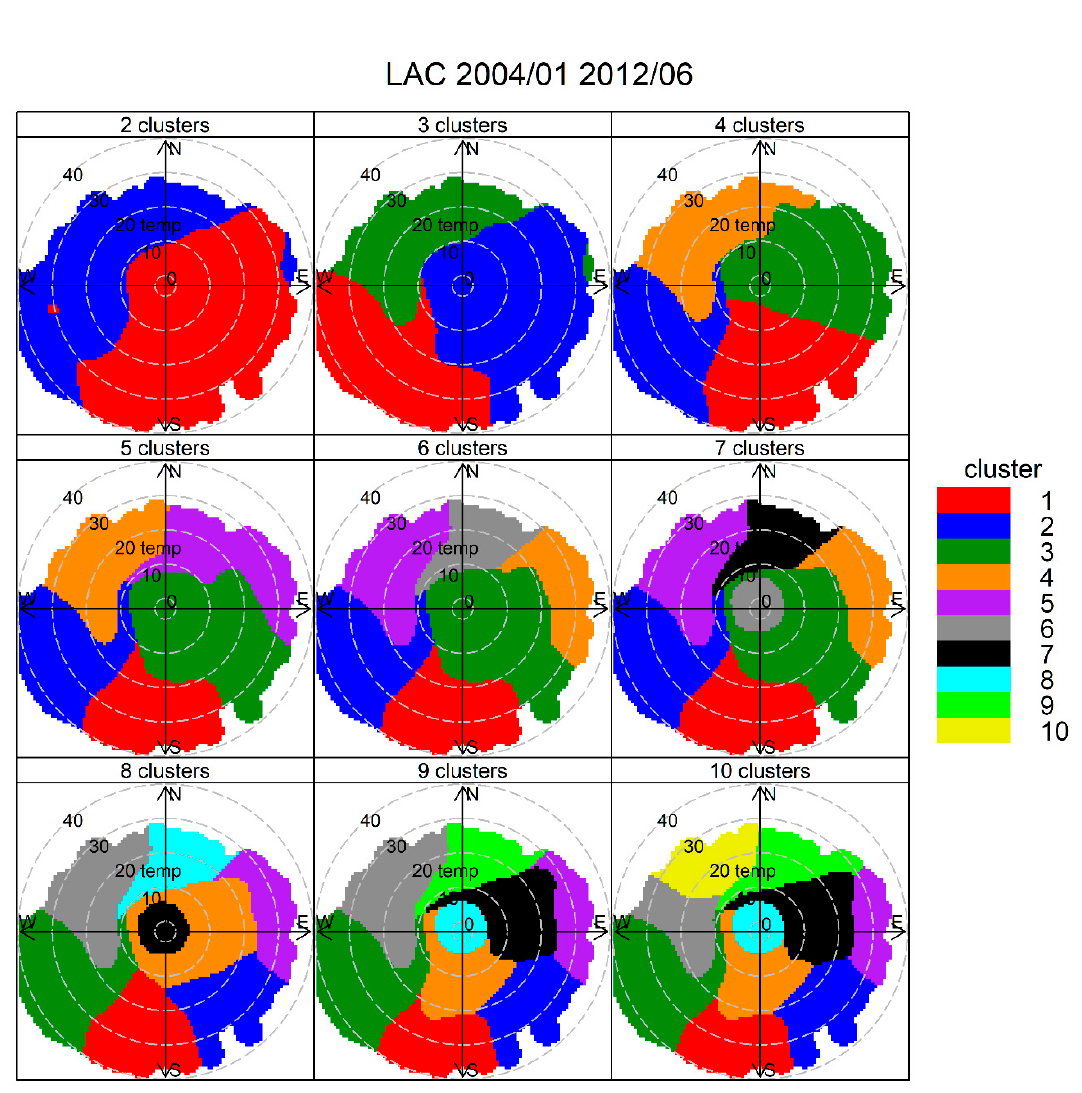
Figure 12. Cluster analysis source apportionment results for ambient PM 2.5 at Santiago, 2004 / 01–2012 / 06, for 2–10 cluster solutions.